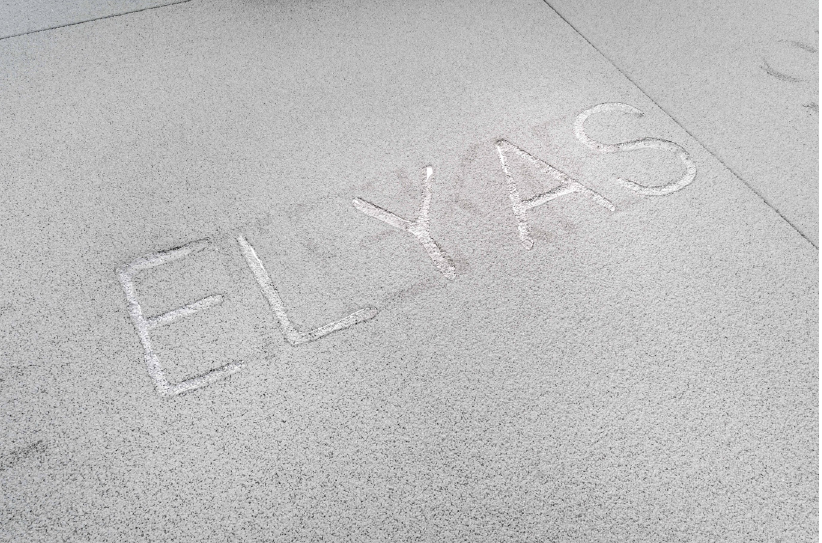
Fig. 18 Doris Salcedo, Palimpsesto 2017, Madrid, Museo Reina Sofía, Palacio de Cristal (detail). © White Cube, photographer Patrizia